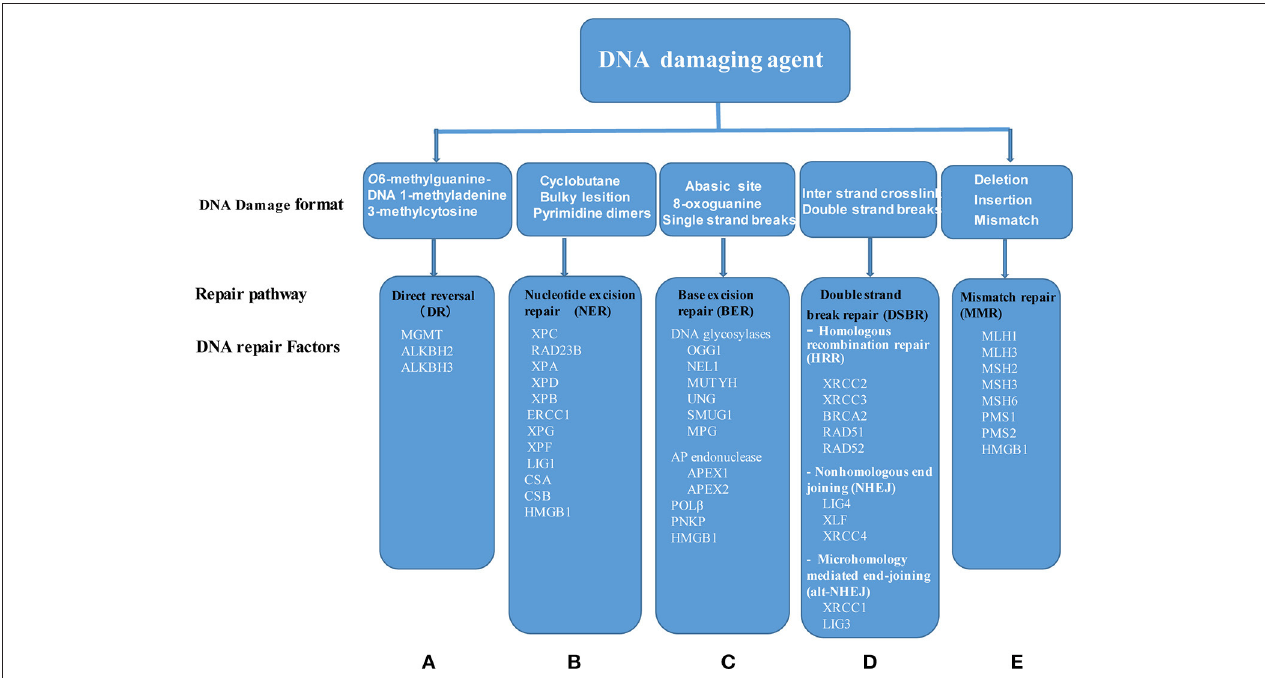
FIGURE 3 | Five DNA damage repair systems have been characterized including: (A) DR, Direct reversal; (B) NER, Nucleotide excision repair; (C) BER, Base excision repair; (D) DSBR, Double strand break repair, and (E) MMR, mismatch repair. Of note, DSBR is divided into three major pathways: Homologous recombination repair, nonhomologous end joining and microhomology mediated end-joining. Each of DNA change repair systems are triggered by specific DNA damage agents. Of note, HMGB1 is involved in three pathways, NER, BER, and MMR. MGMT, O6-methylguanine-DNA methyltransferase; ALKBH2, AlkB, alkylation repair homolog 2; ALKBH3, AlkB, alkylation repair homolog 3; XPC, Xeroderma pigmentosum, complementation group C; RAD23B, RAD23 homolog B; XPA, Xeroderma pigmentosum, complementation group A; XPD, Excision repair cross-complementing rodent repair deficiency, complementation group 2; XPB, Excision repair cross-complementing rodent repair deficiency, complementation group 3; ERCC1, Excision repair cross-complementing rodent repair deficiency, complementation group 1; XPG, Excision repair cross-complementing rodent repair deficiency, complementation group 5; XPF, Excision repair cross-complementing rodent repair deficiency, complementation group 4; LIG1, Ligase I, DNA, ATP-dependent; CSA, Excision repair cross-complementing rodent repair deficiency, complementation group 8; CSB, Excision repair cross-complementing rodent repair deficiency, complementation group 6; HMGB1, High mobility group box 1; OGG1, 8-oxoguanine DNA glycosylase; NEIL1, Nei endonuclease VIII-like 1; MUTYH, mutY homolog; UNG, Uracil-DNA glycosylase; SMUG1, Single-strand-selective monofunctional uracil-DNA glycosylase 1; MPG, N-methylpurine-DNA glycosylase; APEX1, APEX nuclease (multifunctional DNA repair enzyme) 1; APEX2, APEX nuclease (apurinic/apyrimidinic endonuclease) 2; POL β , Polymerase (DNA directed), beta; PNKP, Polynucleotide kinase 3 ′ -phosphatase; XRCC2, X-ray repair complementing defective repair in Chinese hamster cells 2; XRCC3, X-ray repair complementing defective repair in Chinese hamster cells 3; BRCA2, Breast cancer 2; RAD52, RAD52 homolog; RAD51, RAD51 homolog; LIG4, Ligase IV, DNA, ATP-dependent; XLF, Nonhomologous end-joining factor 1; XRCC4, X-ray repair complementing defective repair in Chinese hamster cells 4; XRCC1, X-ray repair complementing defective repair in Chinese hamster cells 1; LIG3, Ligase III, DNA, ATP-dependent; MLH1, MutL homolog 1; MLH3, MutL homolog 3; MSH2, MutS homolog 2; MSH3, MutS homolog 3; MSH6, MutS homolog 6; PMS1, Postmeiotic segregation increased 1; PMS2, Postmeiotic segregation increased